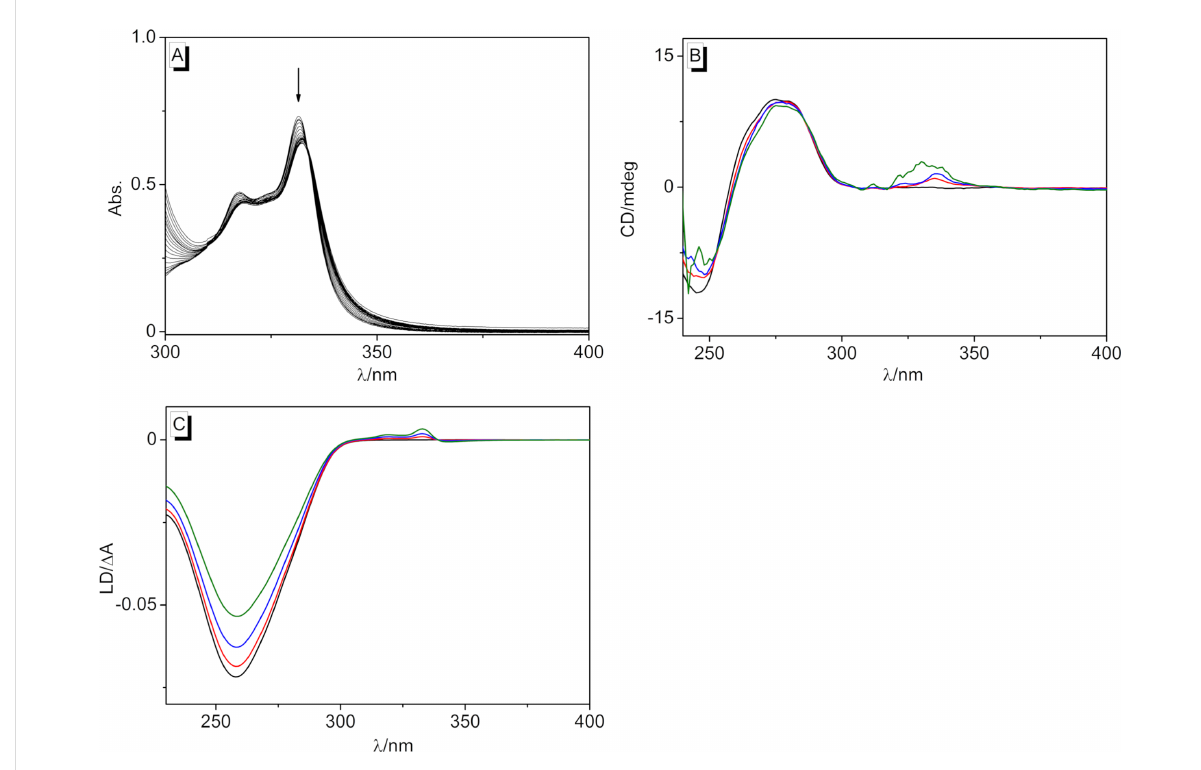
Figure 9: A) Spectrophotometric titration of ct DNA to dimer 4b in BPE buffer ( c L = 20 µM, c ct DNA = 1.45 mM, c ct DNA in base pairs). The arrow indi- cates the changes of absorption upon the addition of ct DNA. B) CD spectra of the dimer 4b with ct DNA (50 µM) in BPE buffer with LDR = 0 (black), 0.5 (red), 1.0 (blue), and 2.0 (green). C) LD spectra of dimer 4b with ct DNA (c = 500 µM) in BPE buffer with LDR = 0 (black), 0.04 (red), 0.08 (blue), and 2.0